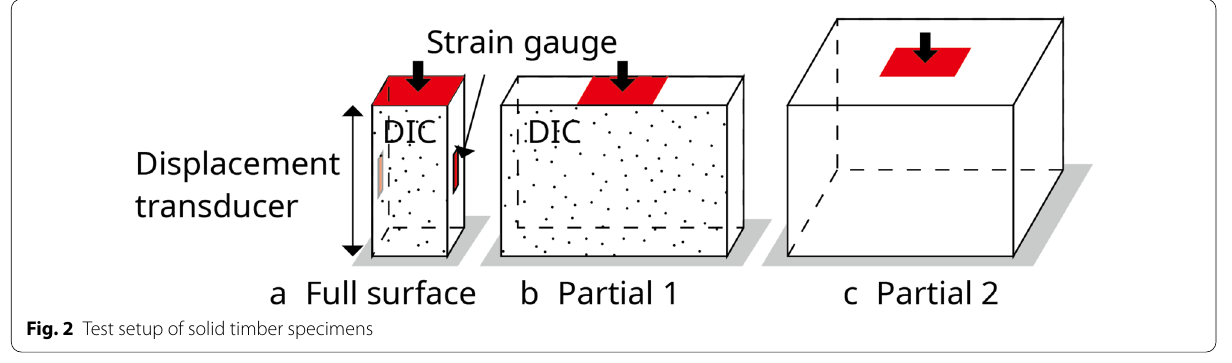
Fig. 2 Test setup of solid timber specimens